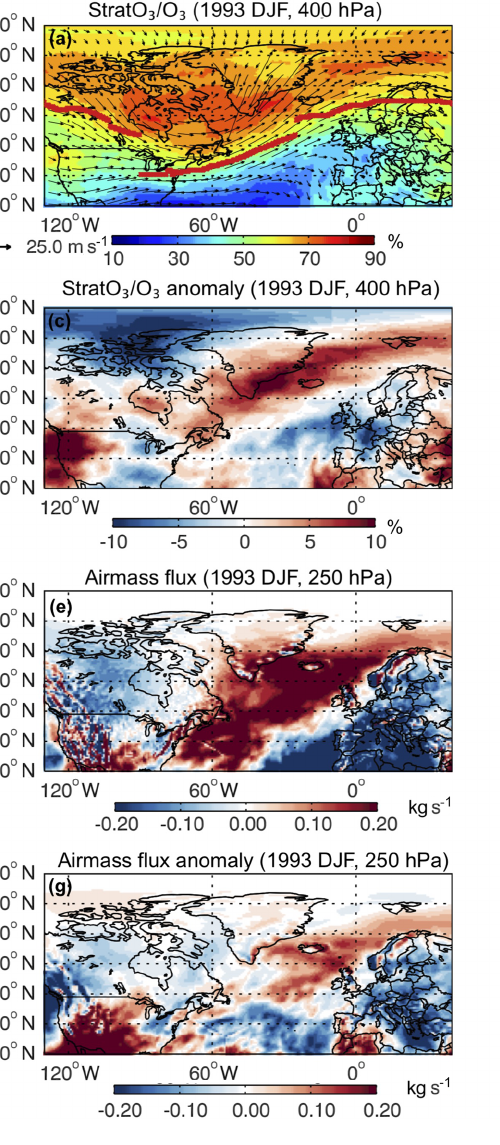
Figure 5. Spatial maps of simulated (a, b) StratO 3 / O 3 ratio and (c, d) its anomaly at 400hPa and (e, f) air mass flux and (g, h) its anomaly at the seasonal mean tropopause pressure in the winter (left) and spring (right) of 1993. The seasonal mean tropopause pressure in the model averaged from 30 to 80 ◦ N is around 250hPa in winter and around 300hPa in spring. Thin black arrows in first row represent the prevailing wind pattern at 400hPa. Thick red lines indicate the jet locations, where the strongest winds